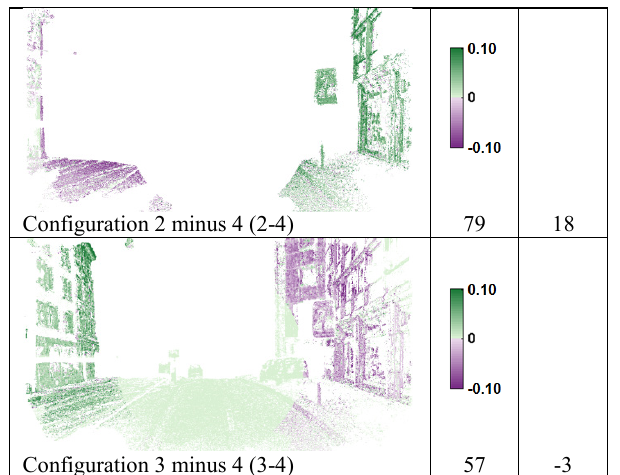
Table 4. Deviations of depth maps generated by the SURE triangulation module